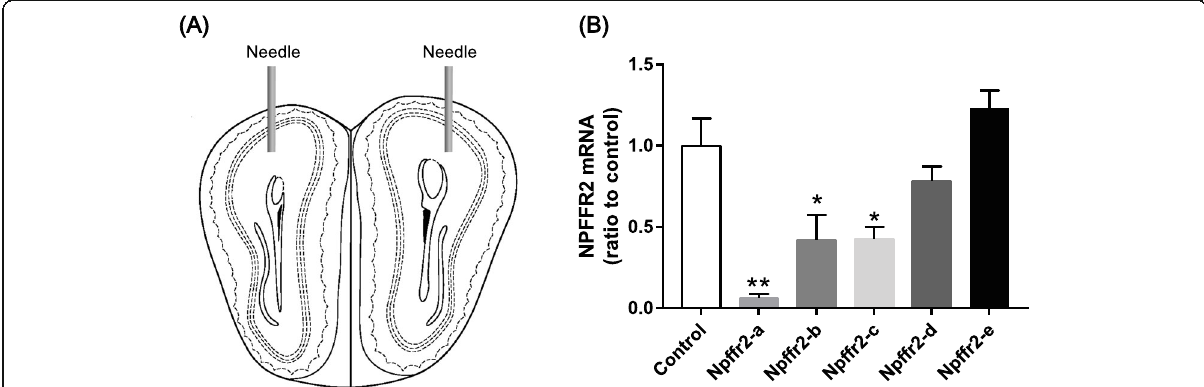
Fig. 2 The effect of Npffr2 gene silencing in the olfactory bulb of WT mice. a The illustration of the injection sites in bilateral olfactory bulb. b The Npffr2 gene was silenced by Npffr2 LV-shRNA. Mice were injected in the olfactory bulb with one of five different Npffr2 LV-shRNAs (from Npffr2 -a to Npffr2 -e). After one week, olfactory bulb tissues were collected to measure Npffr2 mRNA. Data are represented as the mean ± SEM and were analyzed by unpaired Student ’ s t -test. ** p < 0.01; * p < 0.05, compared to the control ( N = 4 per